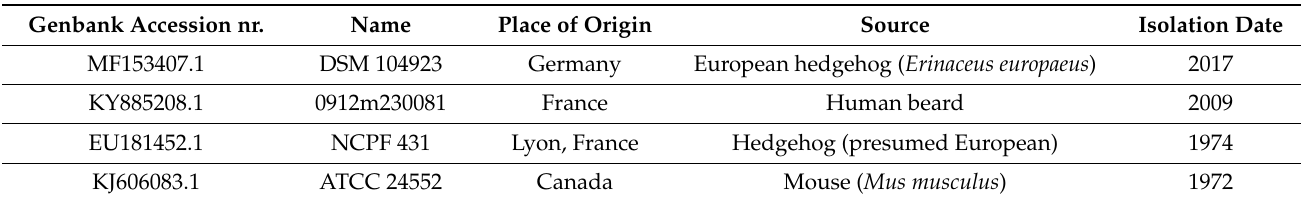
Table 2. Overview of sequences on genbank of similar ITS genotype as T. cf. erinacei strains IHEM 19629 and IHEM 25164. Genbank Accession